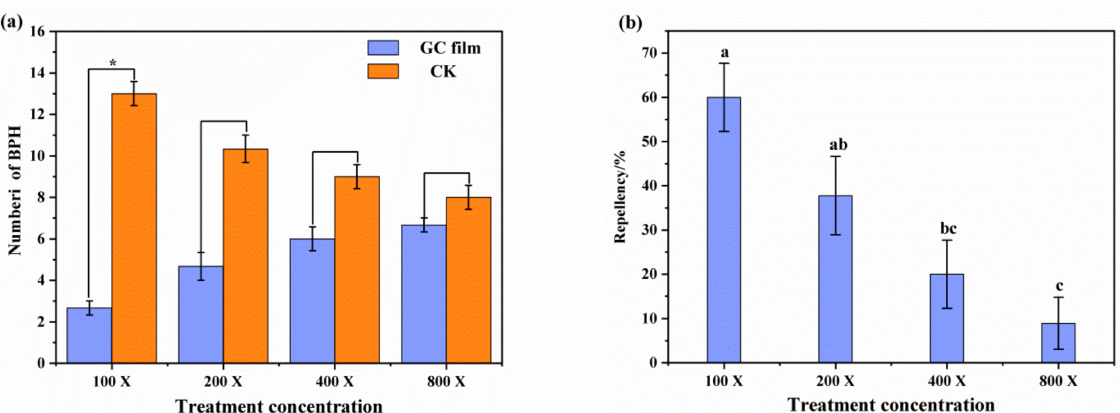
Figure 1. The feeding choice of BPHs and repellent effect of GC film on BPHs after treatment for 4 h. ( a ) The number of BPHs landed at GC film-treated rice seedlings (blue) and water-treated rice seedlings (brown). ( b ) The repellency of GC film to BPH at 100 dilution multiple (100 × ), 200 dilution multiple (200 × ), 400 dilution multiple (400 × ), and 800 dilution multiple (800 × ). The data are expressed as mean ± SD from three replicates. * different lowercase letters indicate significant difference between the control and treatment at p < 0.05. The same below.